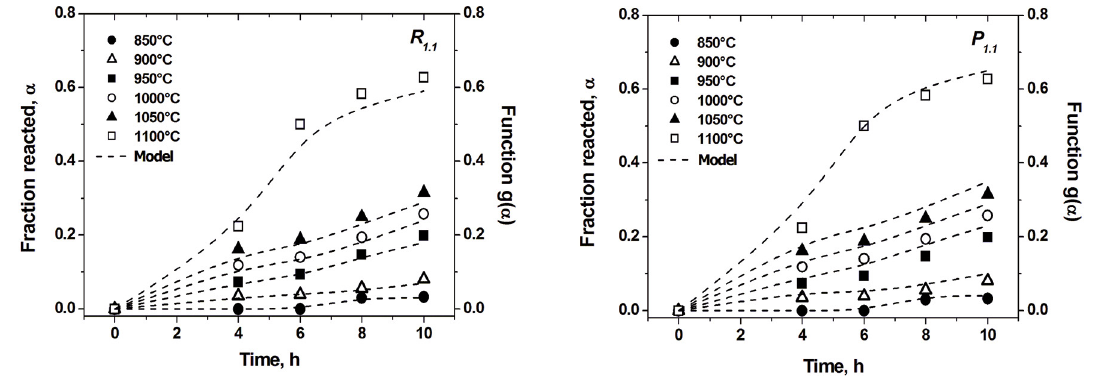
Al O SO as function of temperature and time. 4 6 12 4